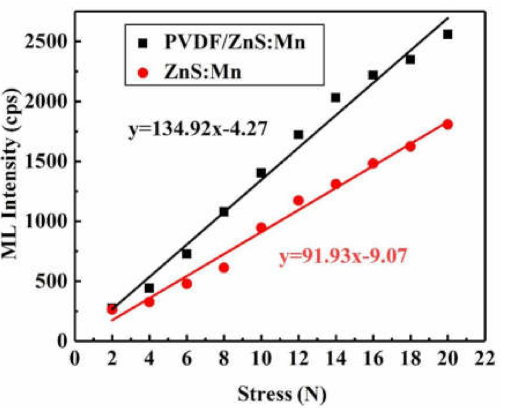
Figure 9. Relationship between the stress and ML intensity of PVDF/ZnS:Mn films and